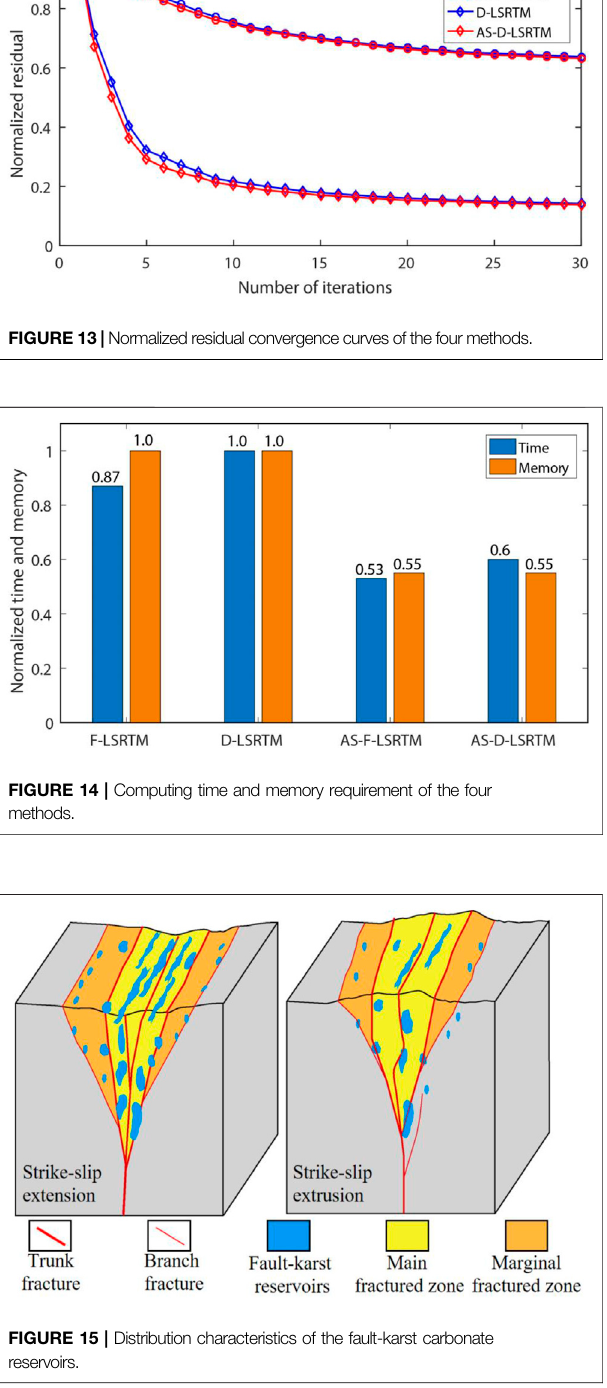
Frontiers in Earth Science |